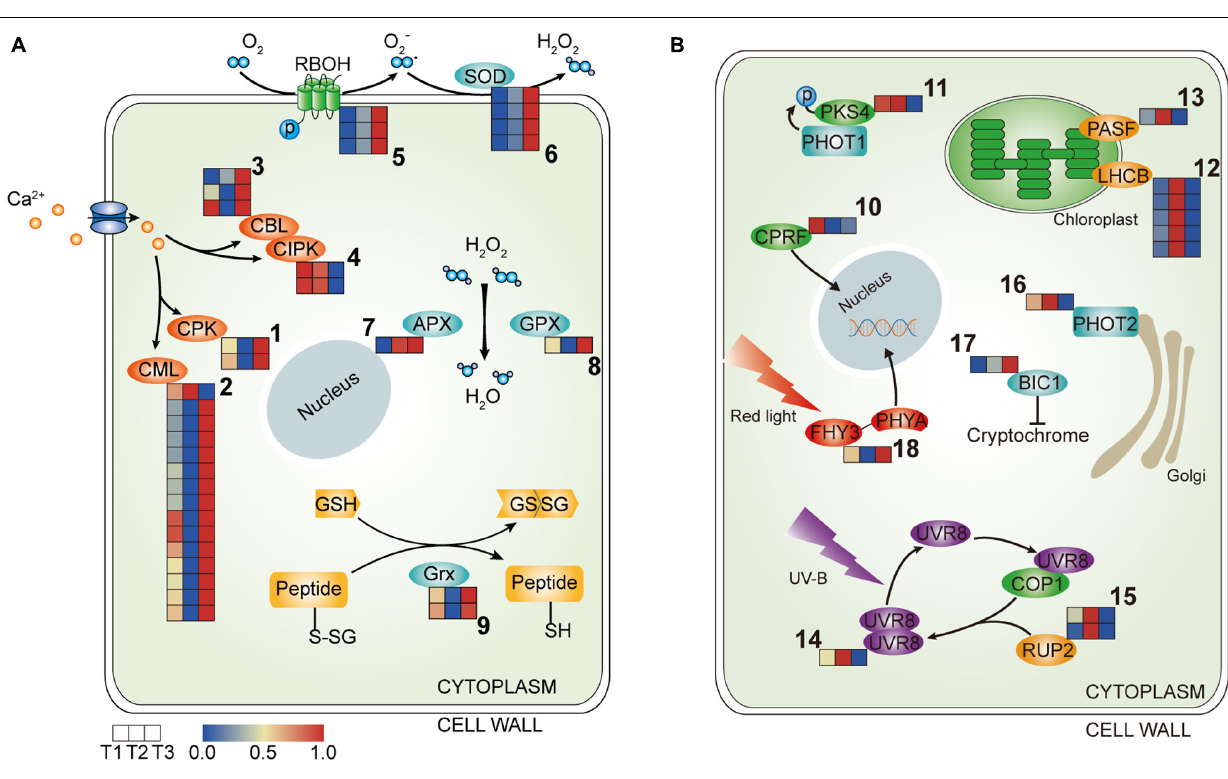
FIGURE 3 | Heatmap of the components involved in the signal transduction in the three petal transcriptomes, T1, T2, and T3. (A) The expressed genes assigned to Ca 2 + signaling and ROS signaling. (B) The expressed genes assigned to light signaling (the corresponding genes are listed in Tables 1 , 2 according to the labeled number “1” to “18” in each map). Red and blue colors indicate upregulated and downregulated transcripts,